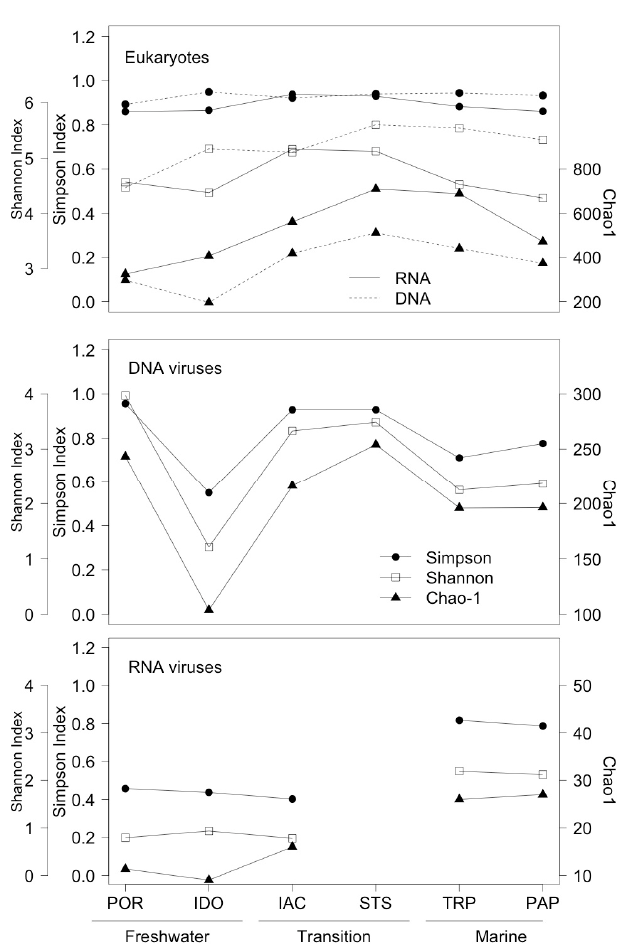
Figure 2. Alpha diversity (Simpson, Shannon, and Chao1 indices) for Eukaryotes (using the 18S rRNA and 18S rDNA gene), DNA viruses, and RNA viruses. Note the changing axes for the Shannon Index and Chao1 Index.